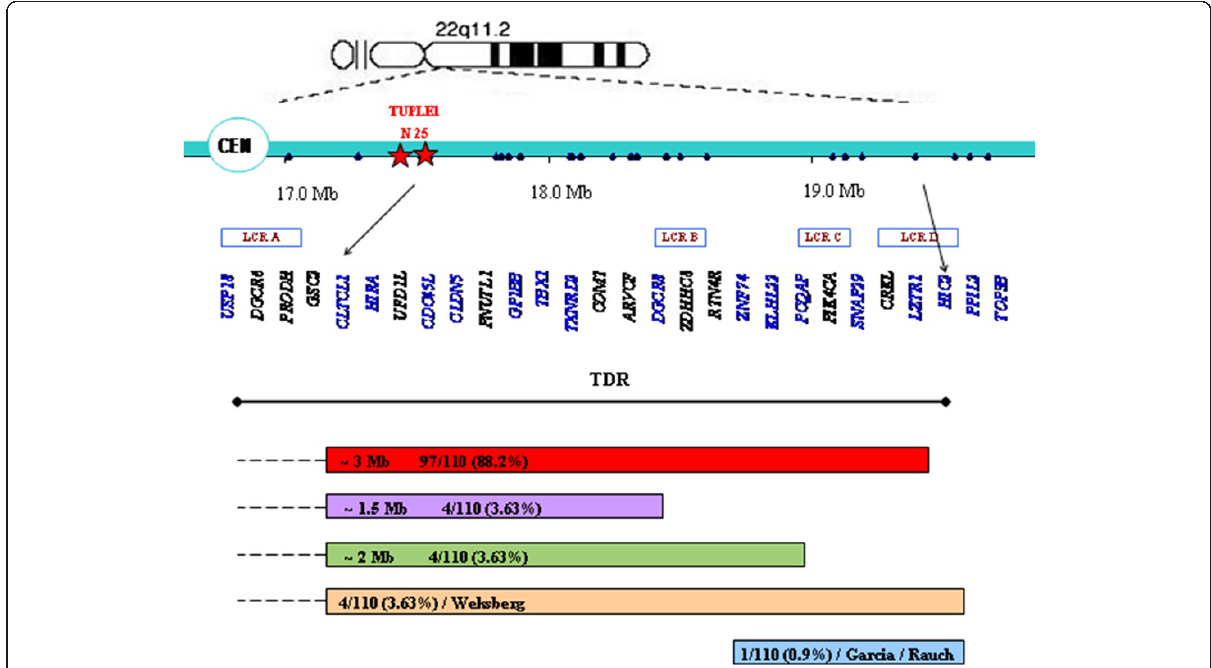
Figure 2 Schematic representation of 22q11.2 deletions detected by MLPA. Genes marked in blue contain MLPA P250-A1 probes. A typically deleted region (TDR) is indicated in red; non-TDR deletions are presented by other colors. FISH probes – N 25 and TUPLE1 ( HIRA ) are indicated by stars.